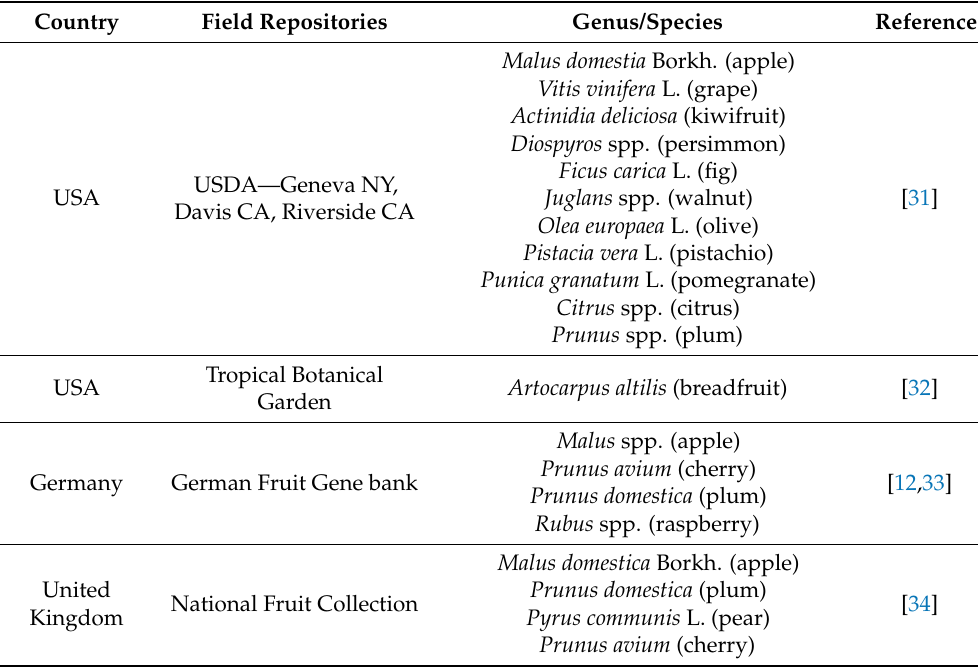
Table 1. Some examples of field repositories maintaining living collections of economically impor- tant crops.